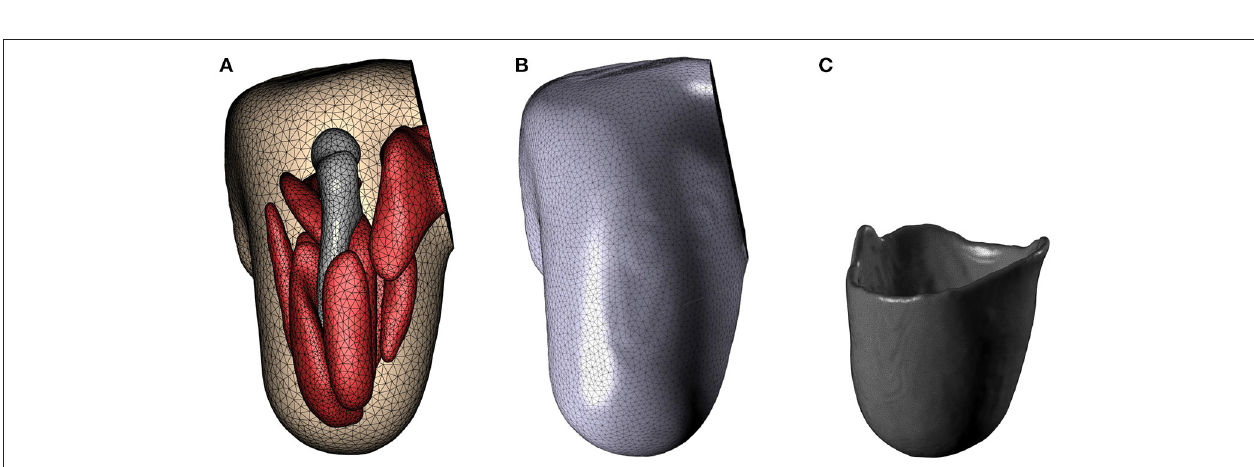
FIGURE 6 | Residual limb model. (A) The residual limb model created in Simpleware ScanIP. The opacity of liner and fat layers have been reduced to reveal the underlying bone and muscles. (B) The liner around fat/skin layer is shown in grey. (C) Model of the original socket worn by the subject.